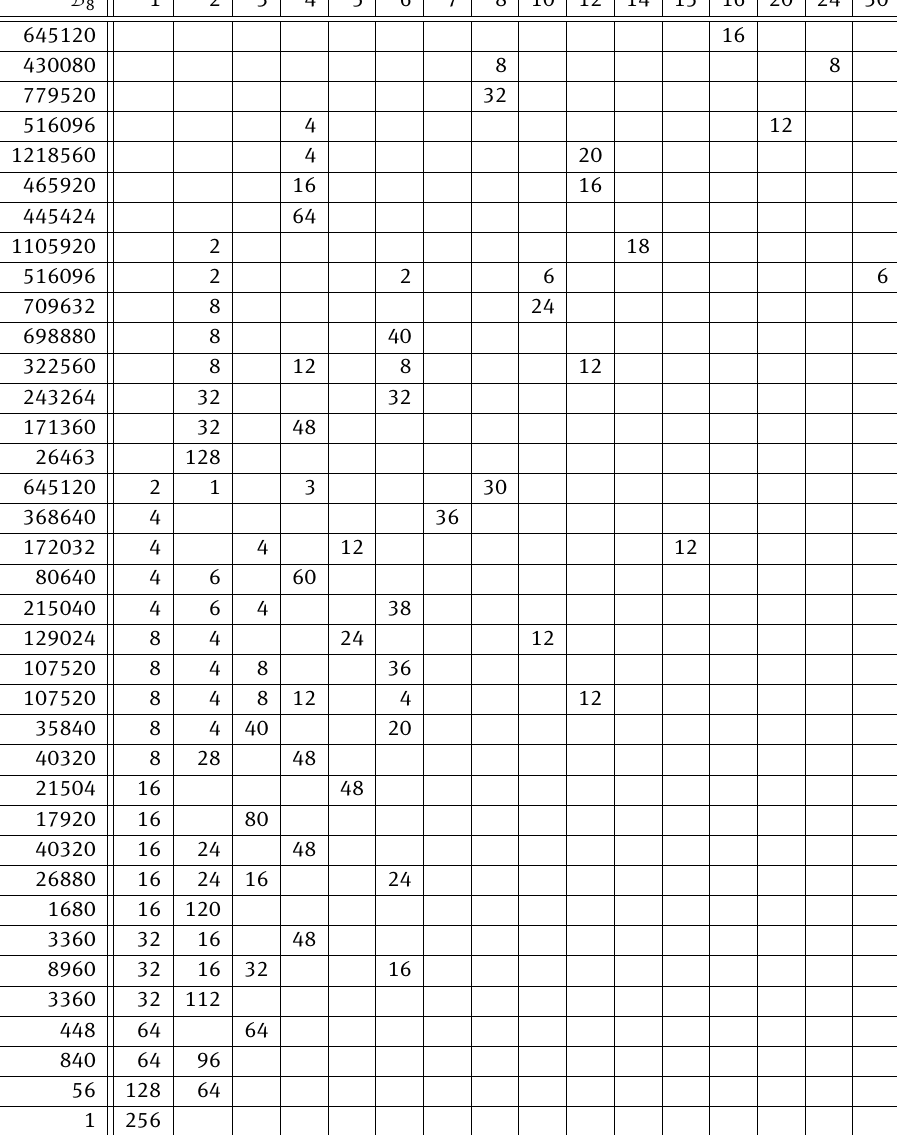
Table 11: The cycle index Z 8 in condensed tabulated